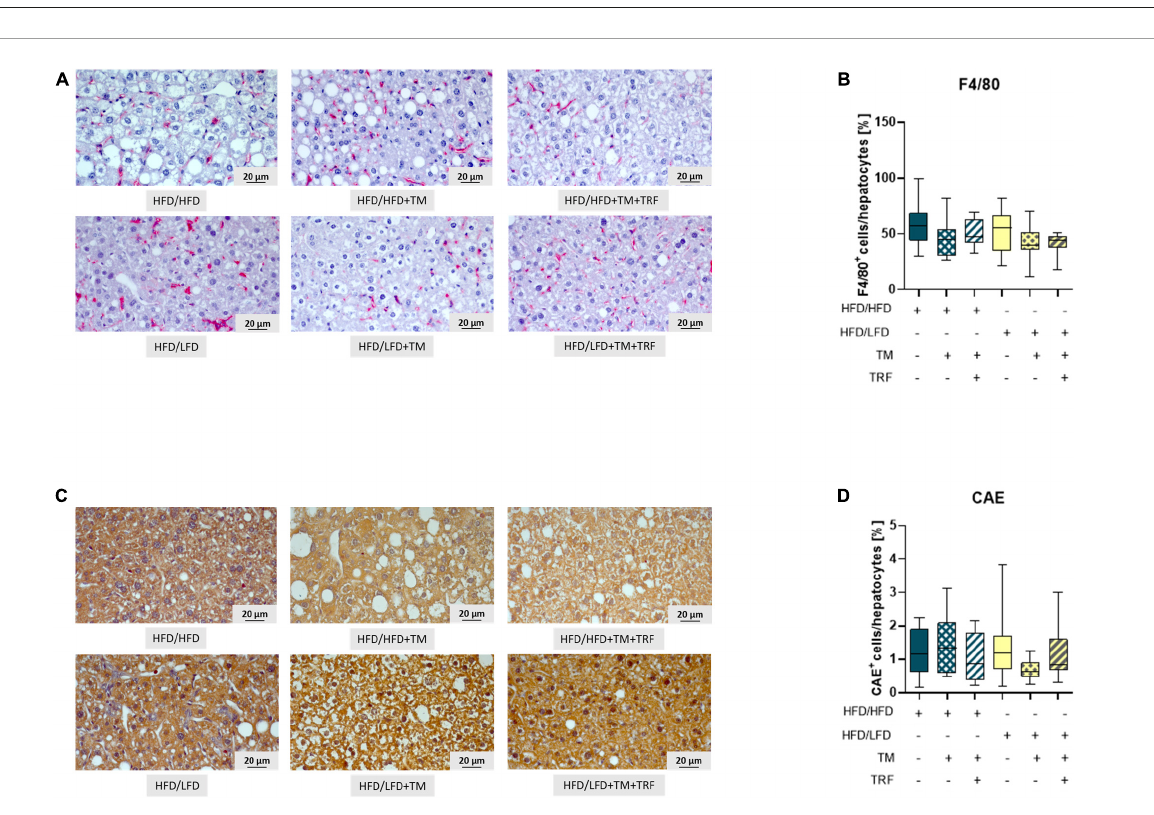
FIGURE4 Representative images (both at 400 × magnification, scale bar representing 20 µ m) of F4/80 (A) as well as CAE-stained livers (C) and quantitative analysis of F4/80+ ( B: HFD/HFD: n = 12, HFD/HFD + TM: n = 10, HFD/HFD + TM + TRF: n = 12, HFD/LFD: n = 13, HFD/LFD + TM: n = 15 or HFD/LFD + TM + TRF: n = 11; total n = 73) as well as CAE+ ( D: HFD/HFD: n = 12, HFD/HFD + TM: n = 9, HFD/HFD + TM + TRF: n = 12, HFD/LFD: n = 13, HFD/LFD + TM: n = 13, HFD/LFD + TM + TRF: n = 11; total n = 70). Blue dots and box plots indicate HFD groups, and yellow dots and box plots indicate dietary change to LFD. Table displays the individual groups, respectively. Table is read from top to bottom; “+” denotes implementation of a given diet or intervention and “ − ” its absence. Significance of differences between groups was tested with either the Kruskal–Wallis test, followed by Dunn’s post hoc test for multiple comparisons (B) or the Brown–Forsythe test, and Welch’s ANOVA with the Tamhane T2 post hoc test for multiple comparisons (D) [ F value ( F ) = 1.313, degree of freedom (DF) = 5]. Data are presented as mean ± SD, and statistical significance was set at p < 0.05. HFD, high-fat diet; LFD, low-fat diet; TM, treadmill; TRF, time-restricted